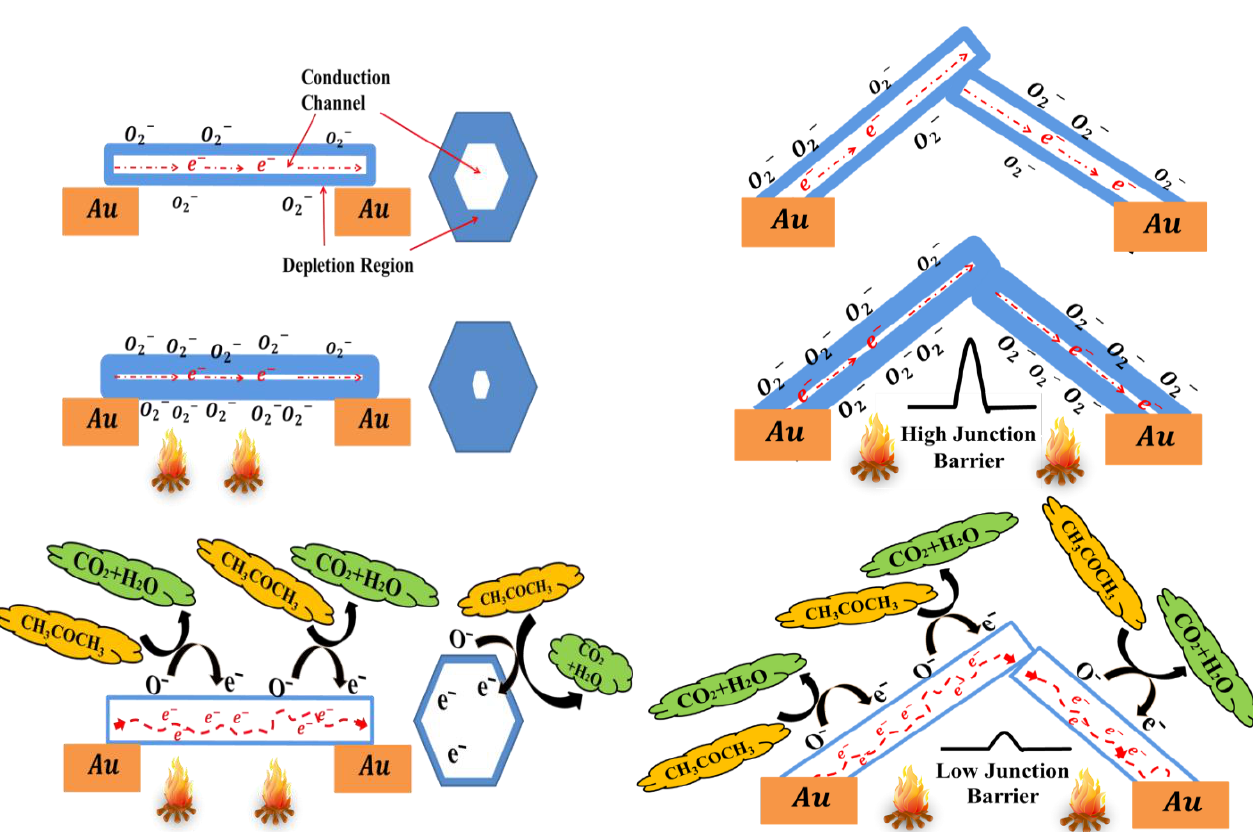
Figure 7. A schematic diagram, representing the carrier generation and transportation in the SNWs vs. BNWs sensors.